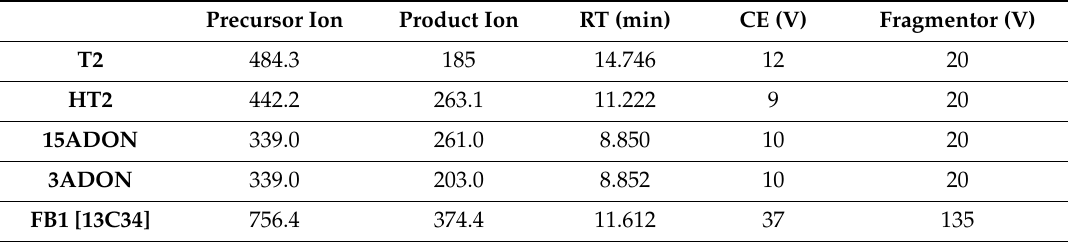
Table 5. Multiple Reaction Monitoring (MRM) parameters for the mycotoxins